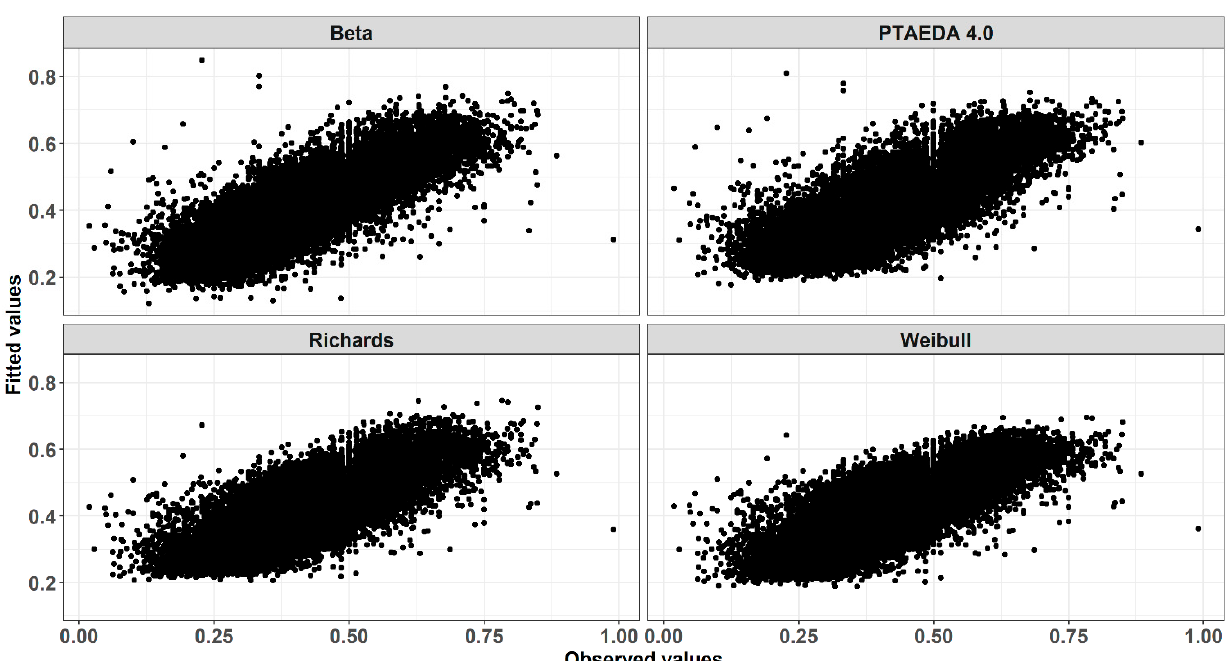
Figure 4. Fitted values for loblolly pine live crown ratio models evaluated within this study plotted against the observed values.